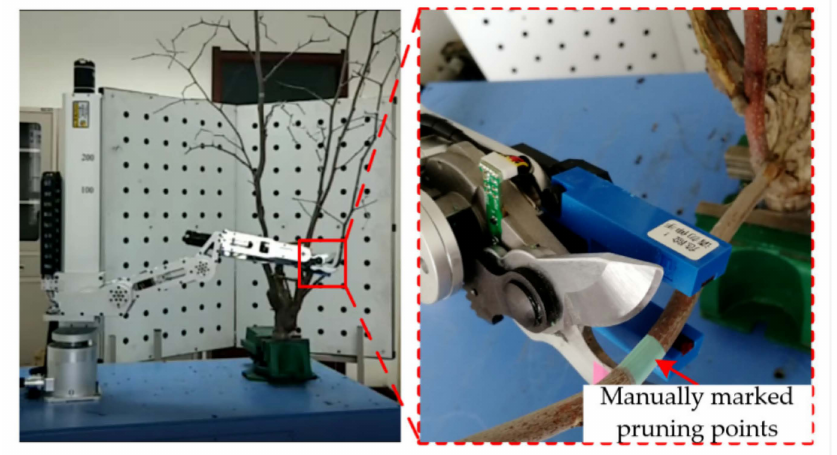
Figure 16. The pruning test